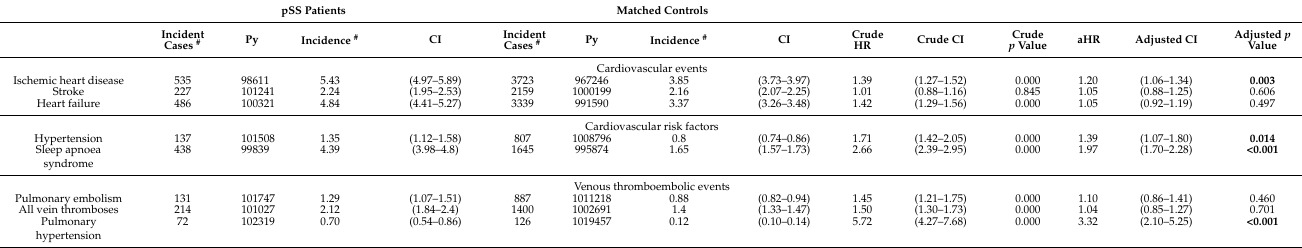
Table 2. Incidence of first hospitalisation for cardiovascular reasons in primary Sjögren’s syndrome patients and controls.